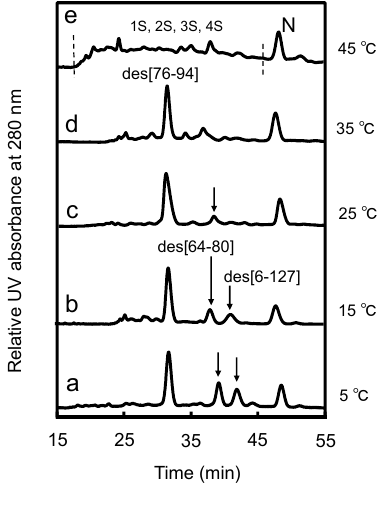
Figure 3. Reverse-phase HPLC chromatograms of the solutions (with AEMTS blocking) obtained from the long-term oxidative folding of HEL using three equivalents of DHS ox at pH 8.0 for 300 min in the presence of 2 M urea. Reaction conditions